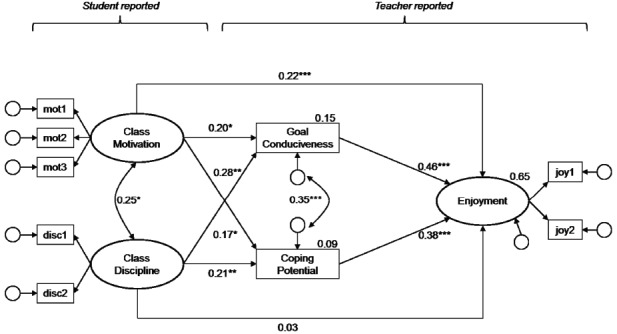
Teacher appraisals mediating the relationship between classroom conditions and teacher enjoyment. Standardized coefficients are shown; the regression coefficients for the latent variable indicators and residuals are not displayed. Estimates at the dependent variables represent explained within-level variance (R2). Model fit: χ2 = 36.97, df = 19, p = 0.01, RMSEA = 0.05, CFI = 0.97, SRMRwithin = 0.04. *p < 0.05, **p < 0.01, ***p < 0.001.